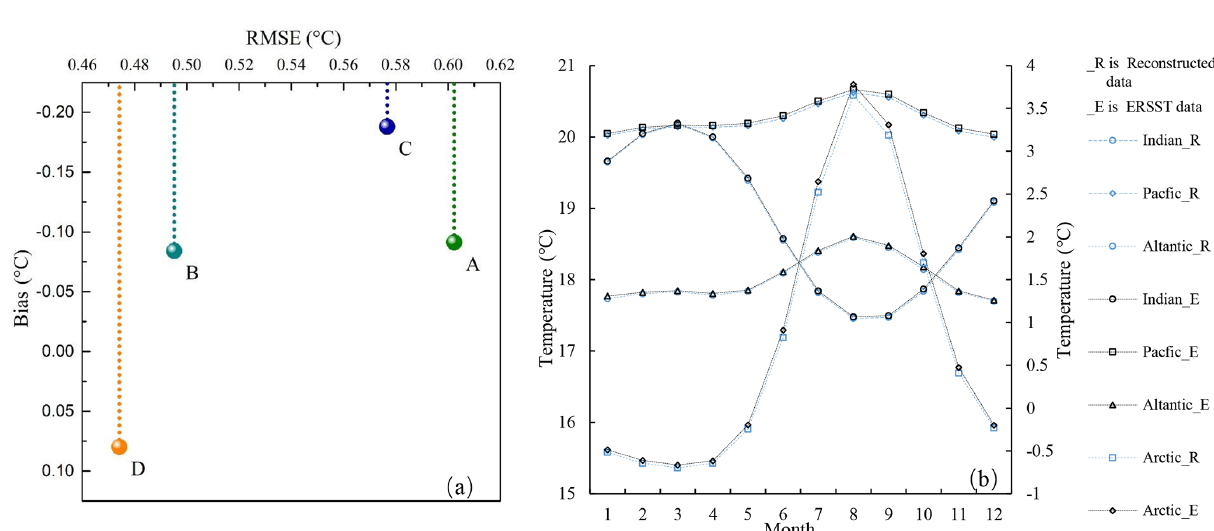
Figure 17. Validation statistics of the reconstructed product and other SST products during 2002–2019. (a) Intercomparison with OISST, where A and C represent the results of OISST and new SSTs against uncorrected in situ SST measurements, respectively. B and D represent the results of OISST and new SSTs against corrected in situ SST measurements, respectively. (b) Intercomparison with ERSST, where black and blue are monthly mean SST changes of ERSST and new SSTs in different ocean from 2002 to 2019.